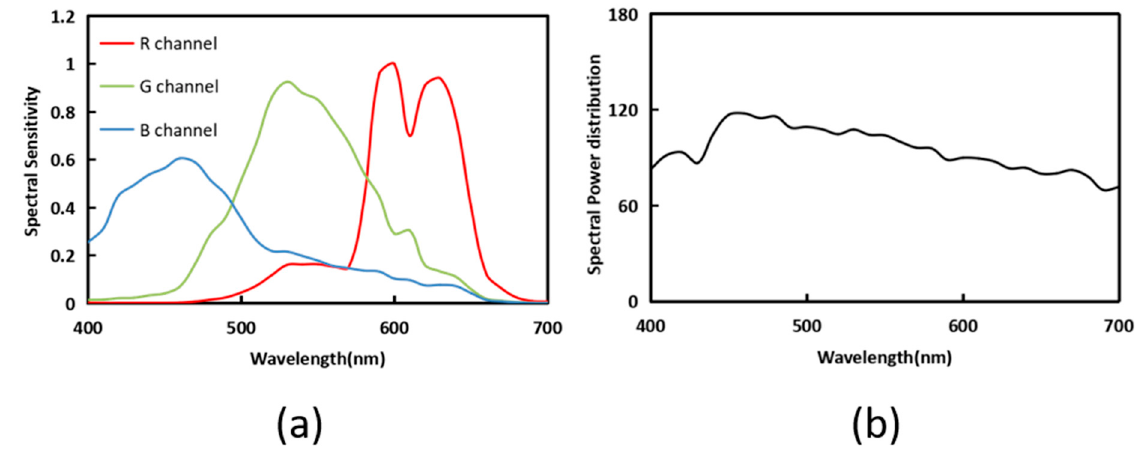
Figure 2. ( a ) Spectral sensitivity functions and ( b ) the spectral power distribution of D65.